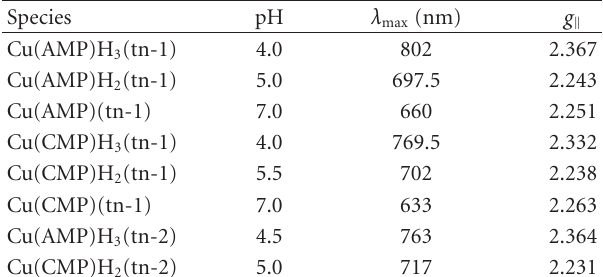
Table 4: Visible and EPR spectral data for Cu(II)/AMP/tn-1, Cu(II) / AMP/tn-2, Cu(II)/CMP/tn-1, and Cu(II)/CMP/tn-2 sys-